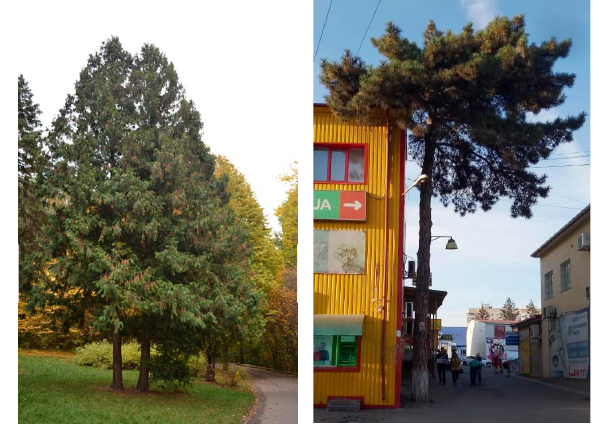
Fig. 1. Th. plicata and P. nigra in urban areas It is known that Th. plicata belongs to the North-West American floristic area [13]. Conifers of this area are charac- terized by resistance to adverse environmental conditions.